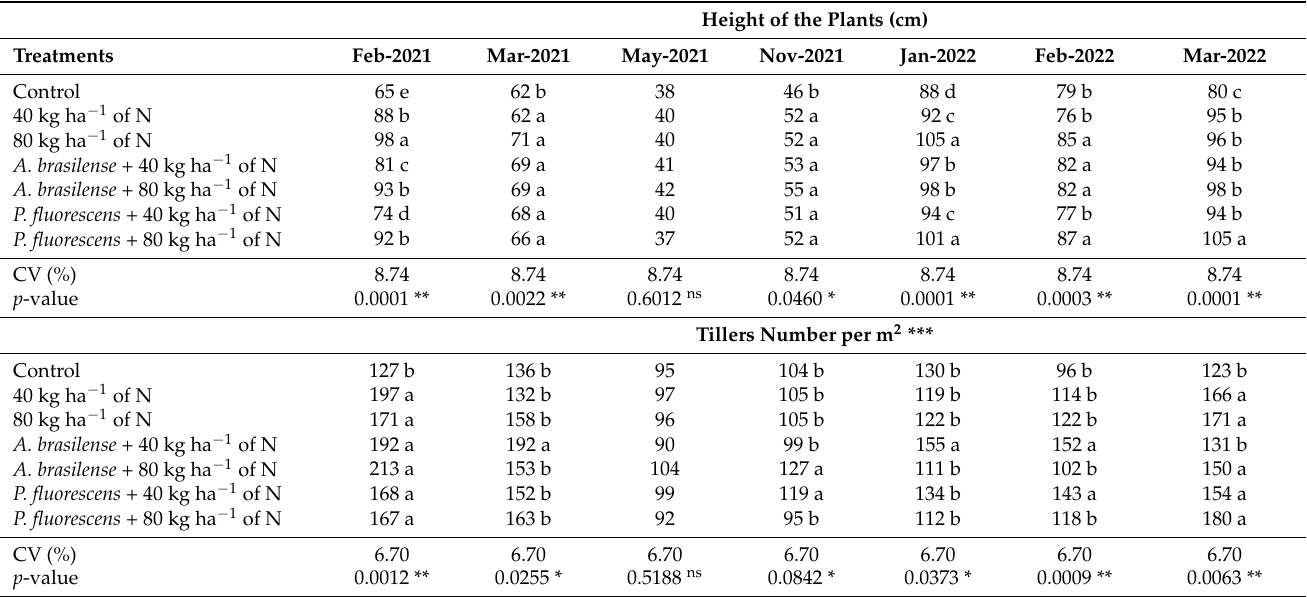
Table 1. Mean plant height and number of tillers per square meter of Megathyrsus maximus cv. BRS Zuri inoculated with